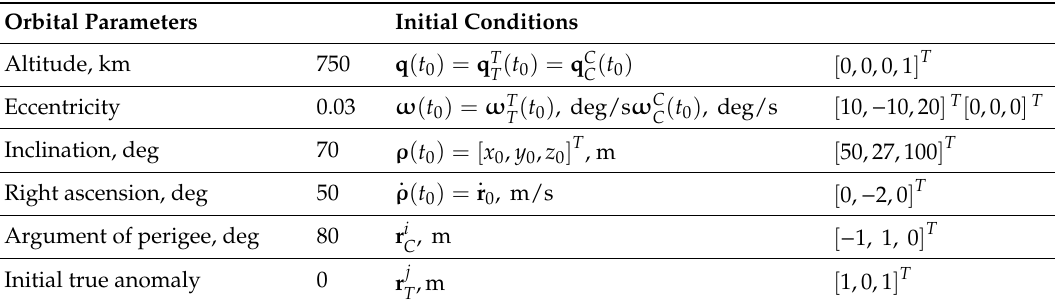
Table 1. Parameters and initial condition of the